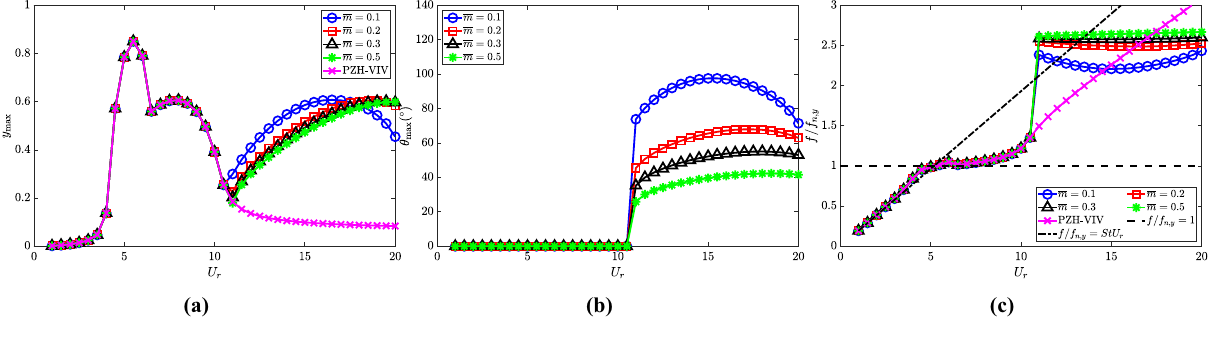
Figure 7. Response characteristics of the system for various m with U r : ( a ) maximum non-dimensional oscillation amplitude ( y max ) of the cylinder, ( b ) maximum angular rotation of the pendulum θ max in degrees ( ◦ ) and ( c ) dominant frequency with respect to cylinder natural frequency f / f n , y . Here, ω r = 1.3 , l d = 0.1 and ζ θ = 0.0011 .